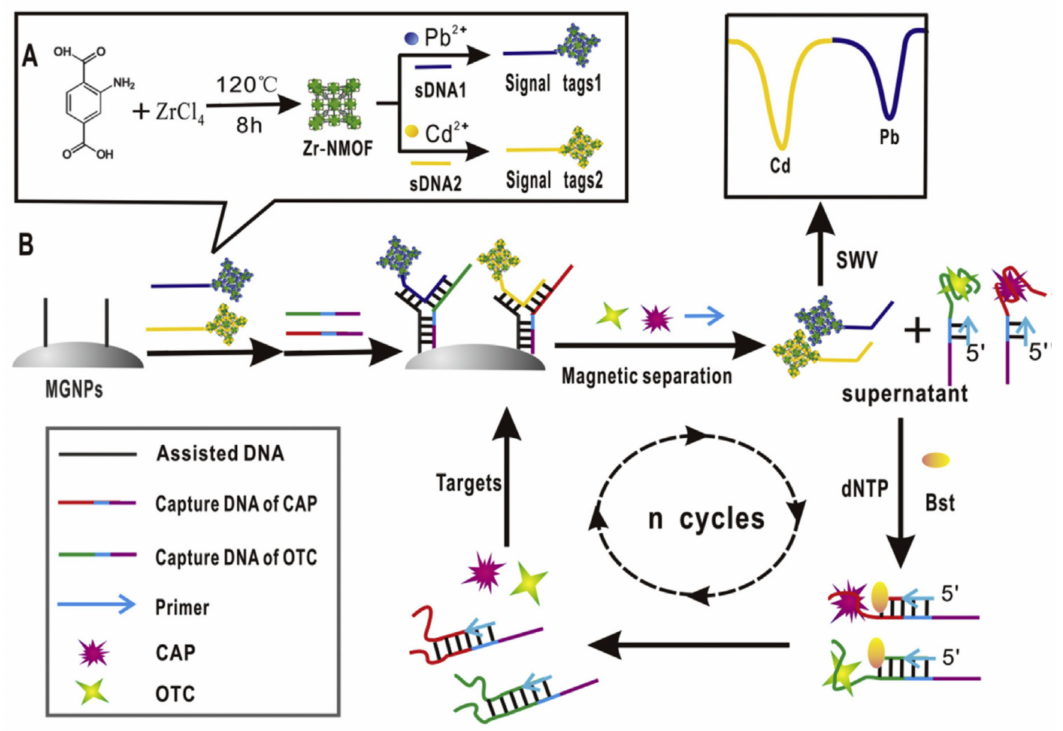
Figure 24. Schematic representation of a multiplex electrochemical aptasensor for the detection of chloramphenicol (CAP) and oxytetracycline (OTC) in milk based on circular strand-replacement DNA polymerization (CSRP). Reprinted from reference [87] with permission from